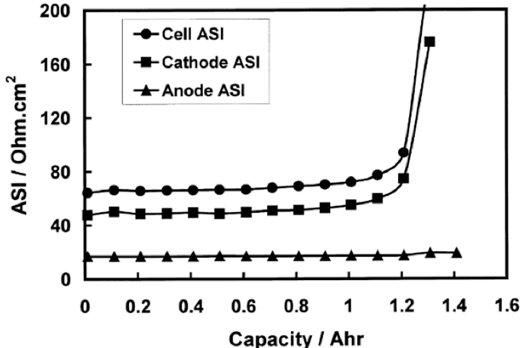
Figure 8. Example of area-specific impedance (ASI) plot for a Li-ion cell equipped with an RE. Reproduced with permission from [95].